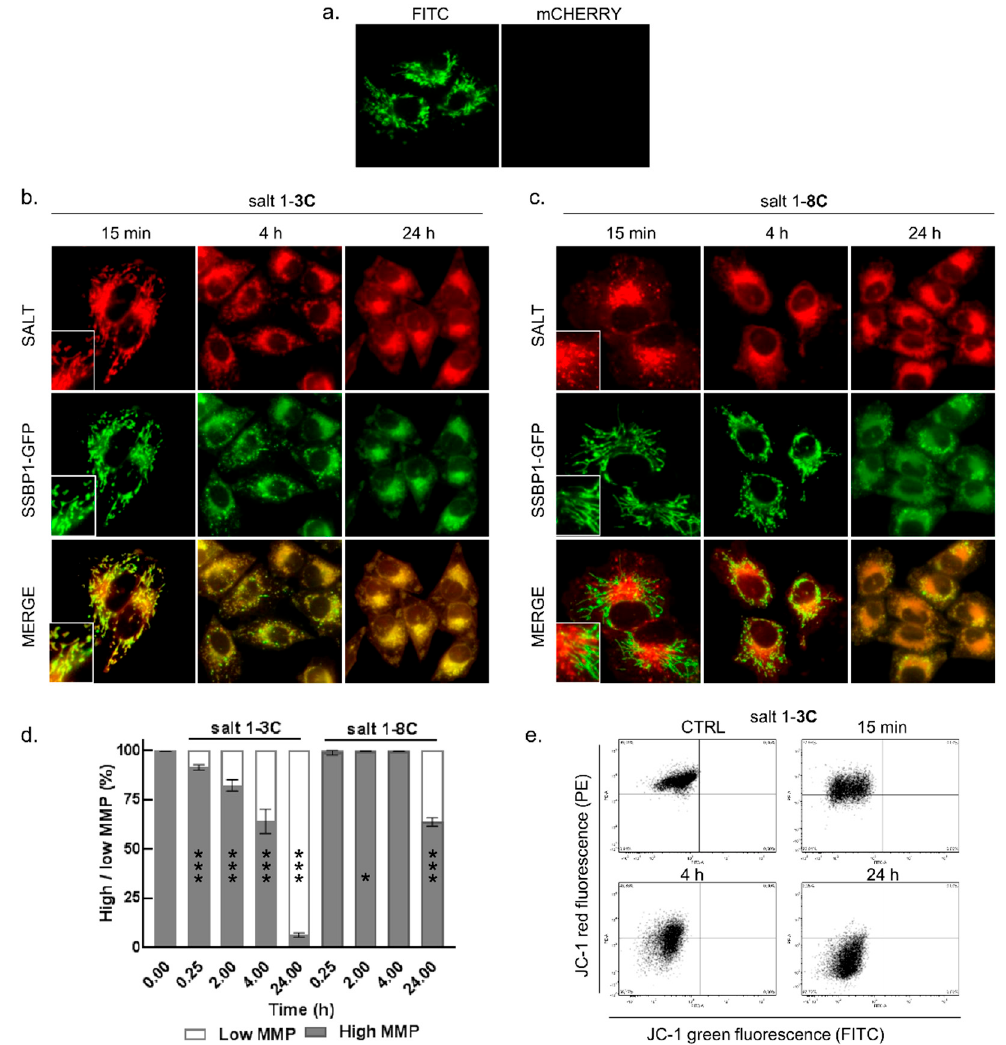
Figure 2. Mitochondrial accumulation and morphology changes after treatment with salt 1- 3C and salt 1- 8C and measurement of mitochondrial membrane potential. ( a ) A-375-SSBP1-GFP (single-stranded DNA-binding protein, mitochondrial-green fluorescent protein) cells detected in green (FITC, λ em = 525 nM) and red (mCherry, λ em = 610 nM) channels. Fluorescence microscopy images of stable A-375-SSBP1-GFP cells (600x magnification) after treatment with 2000 nM salt 1- 3C ( b ) and 5000 nM salt 1- 8C ( c ) for the indicated times (salt 1- 3C and salt 1- 8C in red and mitochondrial SSBP1-GFP in green). Insets show additional software magnification (3 × ). ( d ) Flow cytometry analysis of JC-1 (mitochondrial membrane potential (MMP)). Distribution of low (white) and high (grey) MMP in A-375 cells treated with 2000 nM salt 1- 3C and 5000 nM salt 1- 8C at the indicated times. The results represent the mean ± SD of technical triplicates, each with 10,000 counted cells; * p < 0.05, ** p < 0.01, *** p < 0.001. ( e ) Flow cytometry analysis of JC-1 in A-375 cells treated with 2000 nM salt 1- 3C for 15 min, 4 h, and 24 h, and for untreated cells (CTRL). Upper and lower left quadrants represent aggregates and monomers of JC-1, respectively.